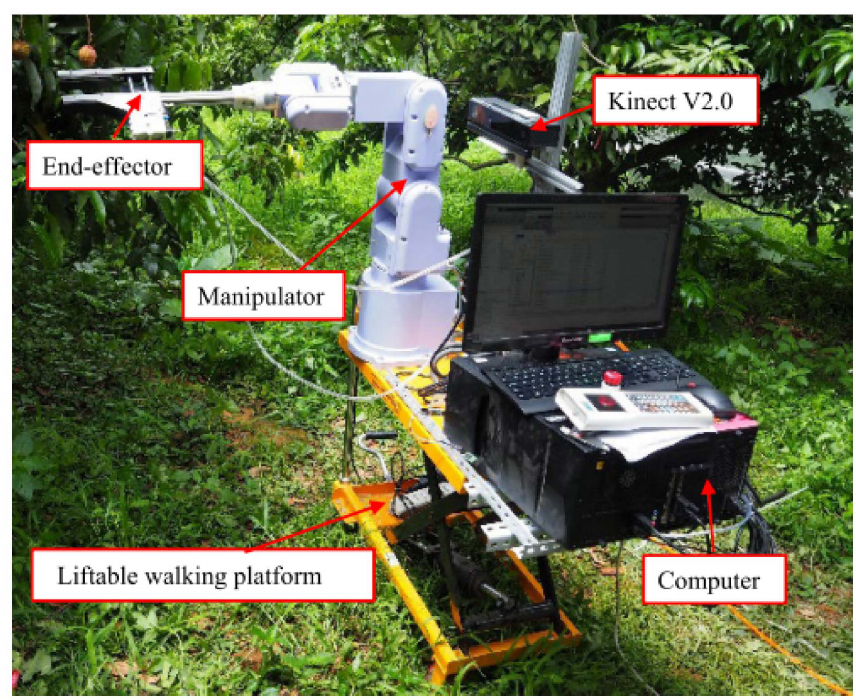
Figure 18. Robotic system for lychee harvesting